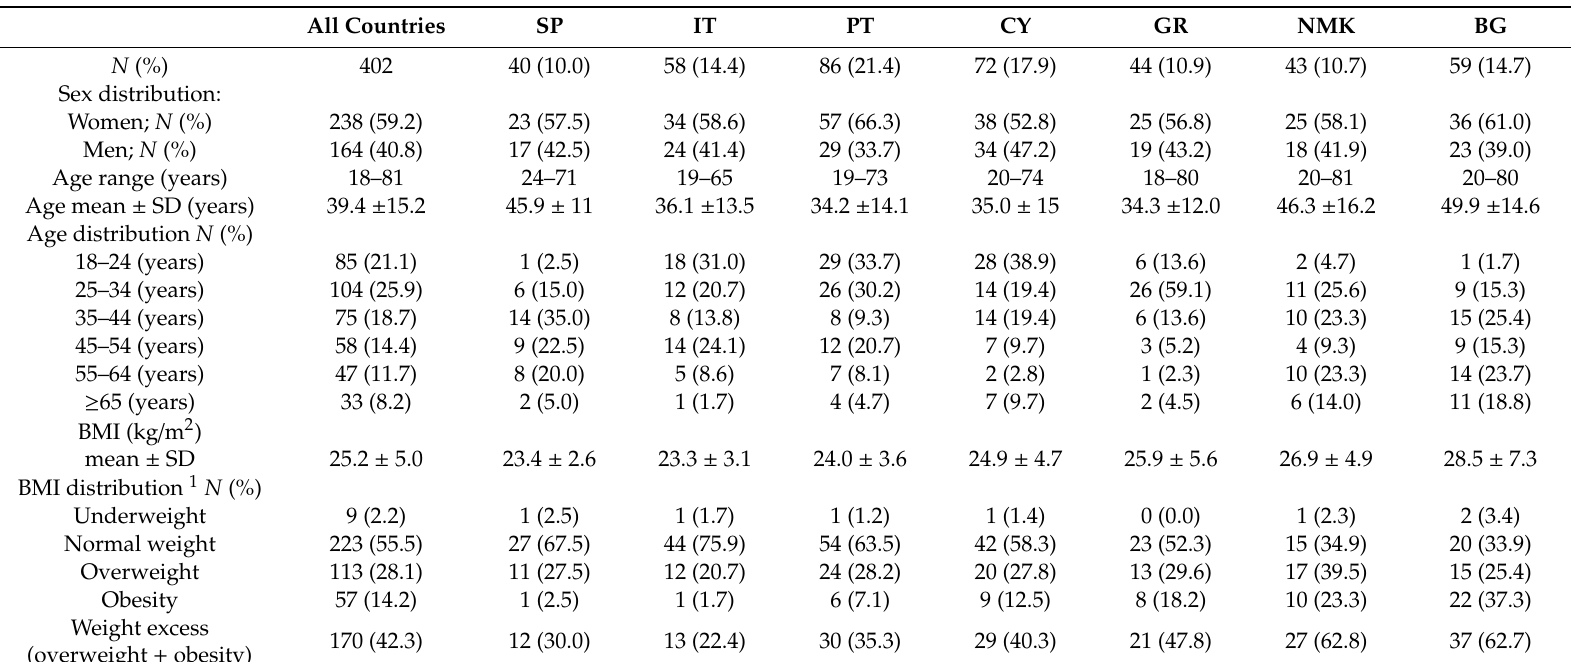
Table 1. Characteristics and distribution of the sample